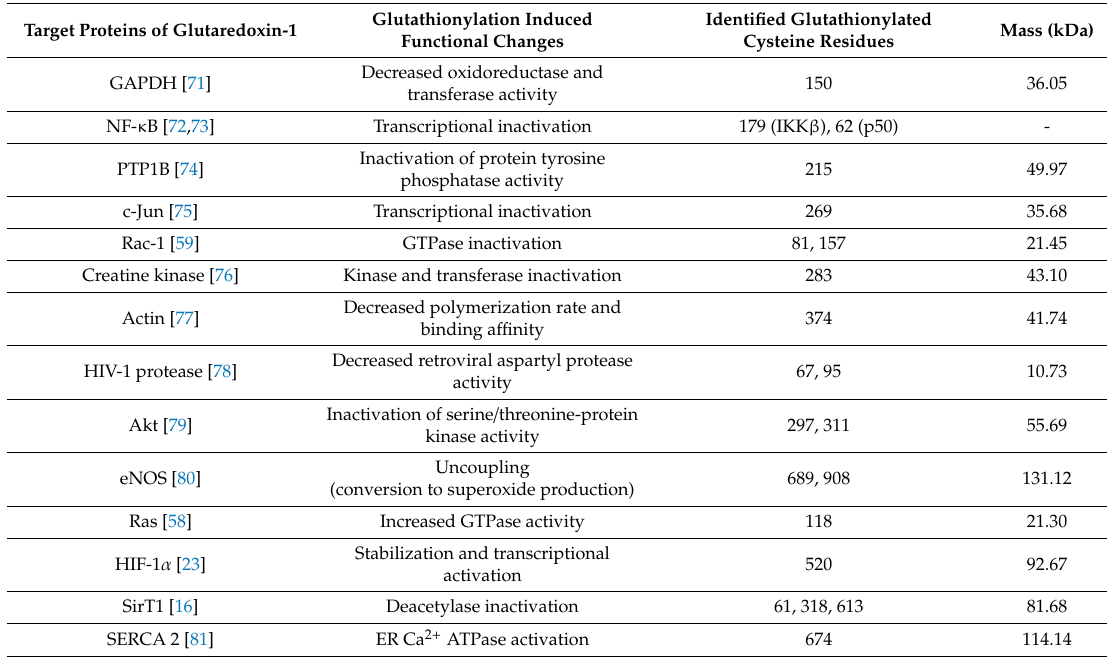
Table 2. Target proteins of glutaredoxin-1. GAPDH, glyceraldehyde 3-phosphate dehydrogenase; PTP1B, protein tyrosine phosphatase 1B; SERCA, sarco / endoplasmic reticulum Ca 2 +